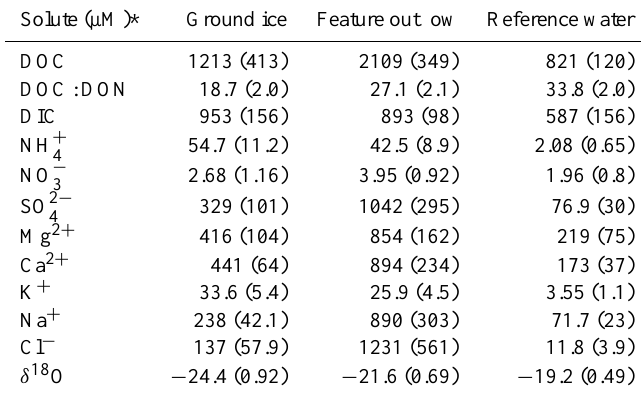
Table 3. Water chemistry for ground ice, thermokarst outflows, and reference